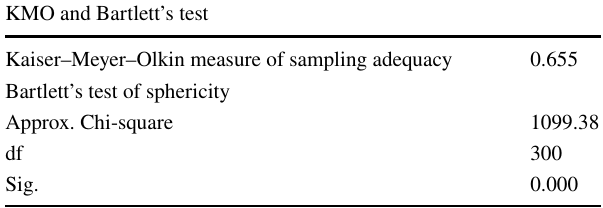
Table 3 Kaiser–Meyer–Olkin value (0.655) of winter-season